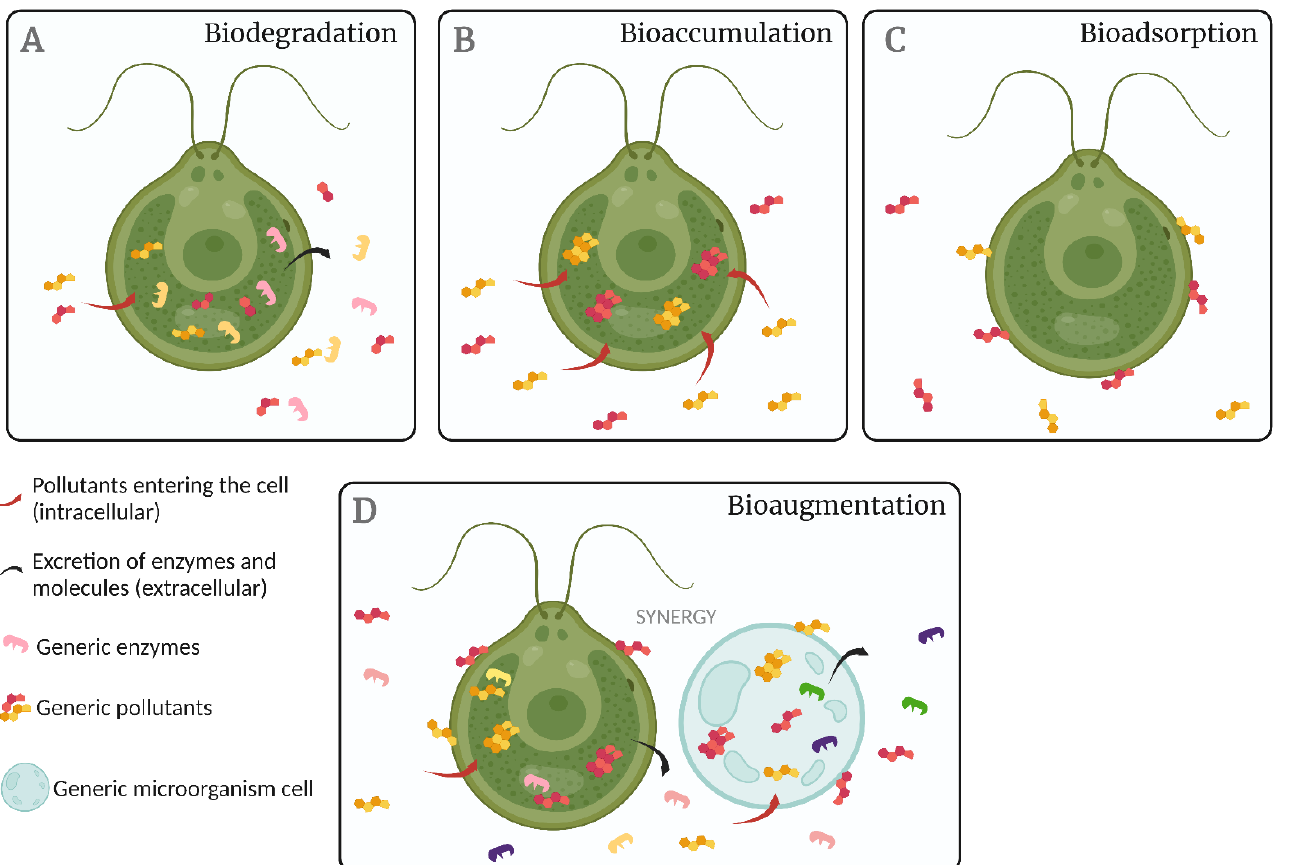
Figure 2. Bioremediation mechanisms at play in microalgae cultures. ( A ) Biodegradation, where the cells directly degrade xenobiotics into innocuous molecules; ( B ) bioaccumulation, where the xenobiotics are not degraded but accumulate in living cells and can be removed with them; ( C ) bioadsorption, where molecules cling to the surface of living or dead cells and can be removed with the biomass; and ( D ) bioaugmentation, where pollutant molecules are degraded in an exchange of metabolites between microalgae and one or more symbionts.